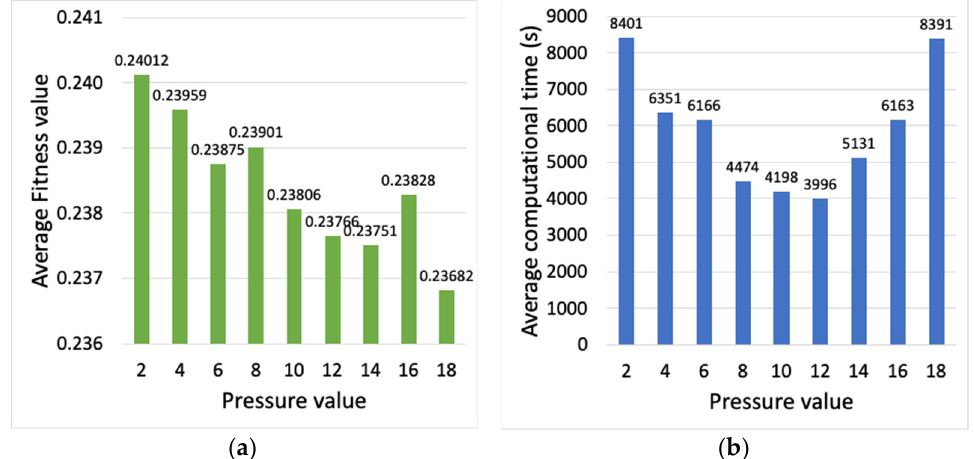
Figure 5. ( a ) Average fitness value of the best individual, ( b ) average computational time (s), vs. pressure.